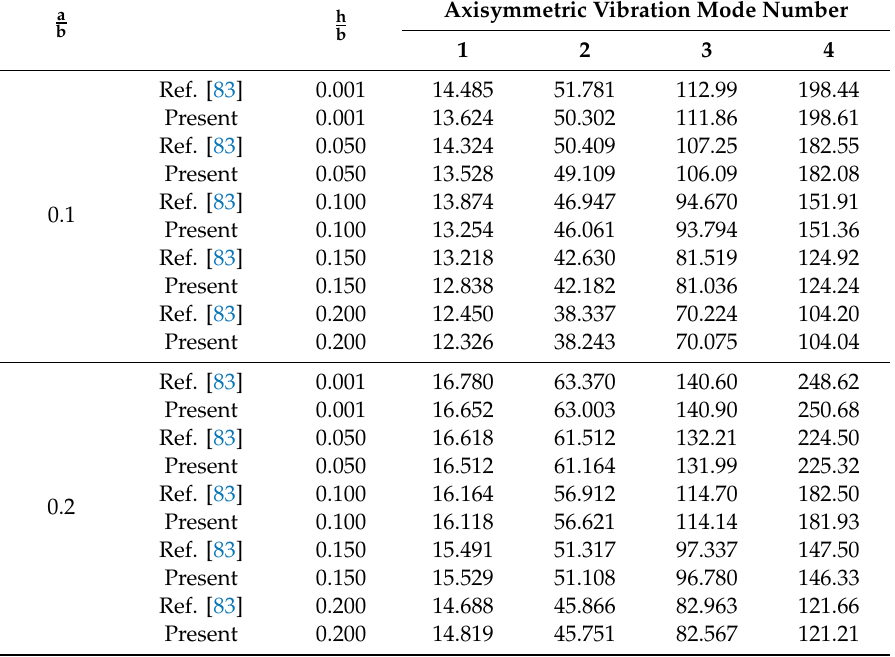
Table 2. Comparison of nondimensional natural frequency of the annular plate for di ff erent axisymmetric vibration mode number, inner radius to outer radius ratio, and thickness to outer radius ratio for simply-simply boundary